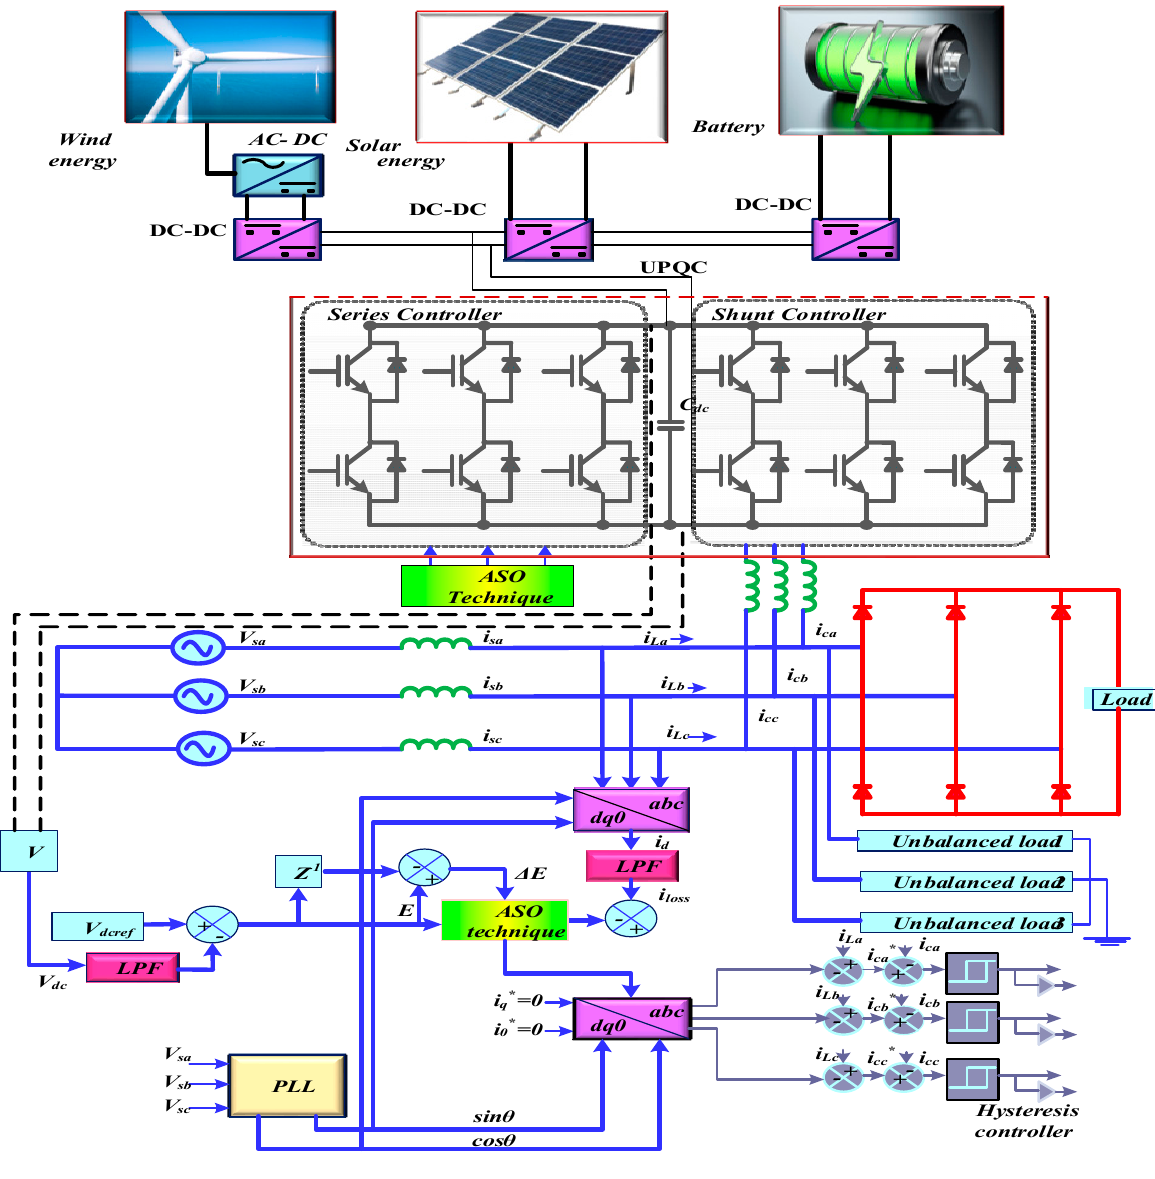
Figure 1. Block diagram of the Proposed System.